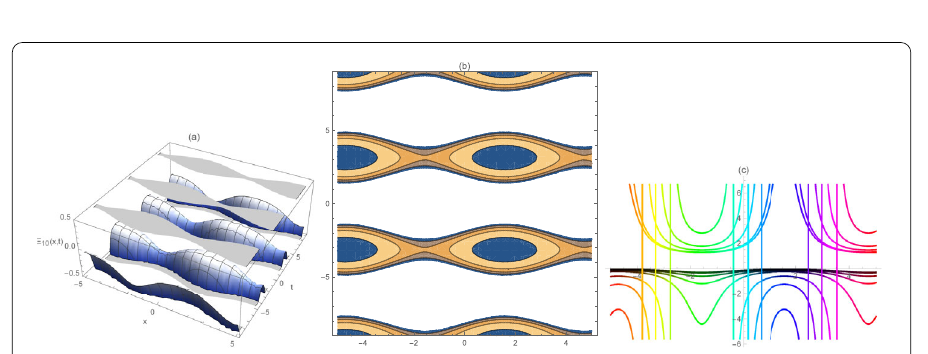
Figure 2 Solitary wave of the Cahn–Allen equation by using Eq. (13) in three- ( a ), two- ( c ) dimensional and contour plot ( b ), when [ σ = 1, α = 2, β = 3], which shows the structure of the dynamics for phase separation in Fe – Cr – X ( X = Mo , Cu ) ternary alloys